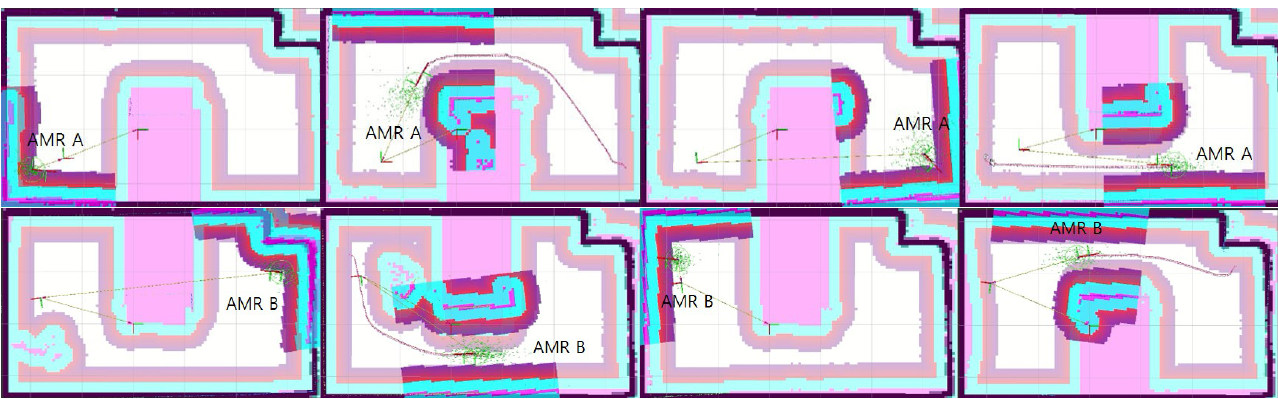
Figure 5. AMR A and B around three boxes under the lane filter.